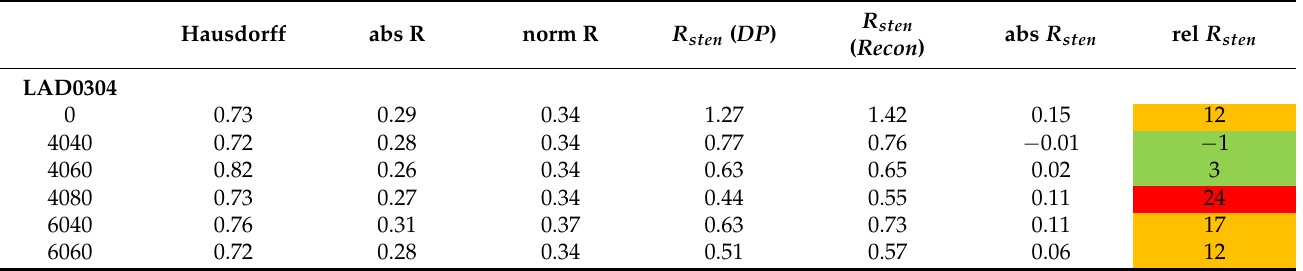
Table 3. Assessment metrics for the LAD cases considered. The Hausdorff distance is computed between the centerlines of the reconstructed artery and the digital phantom. The stenotic radii for the digital phantom (column R sten ( DP ) ) and the reconstruction (column R sten ( Recon ) ) are recorded in